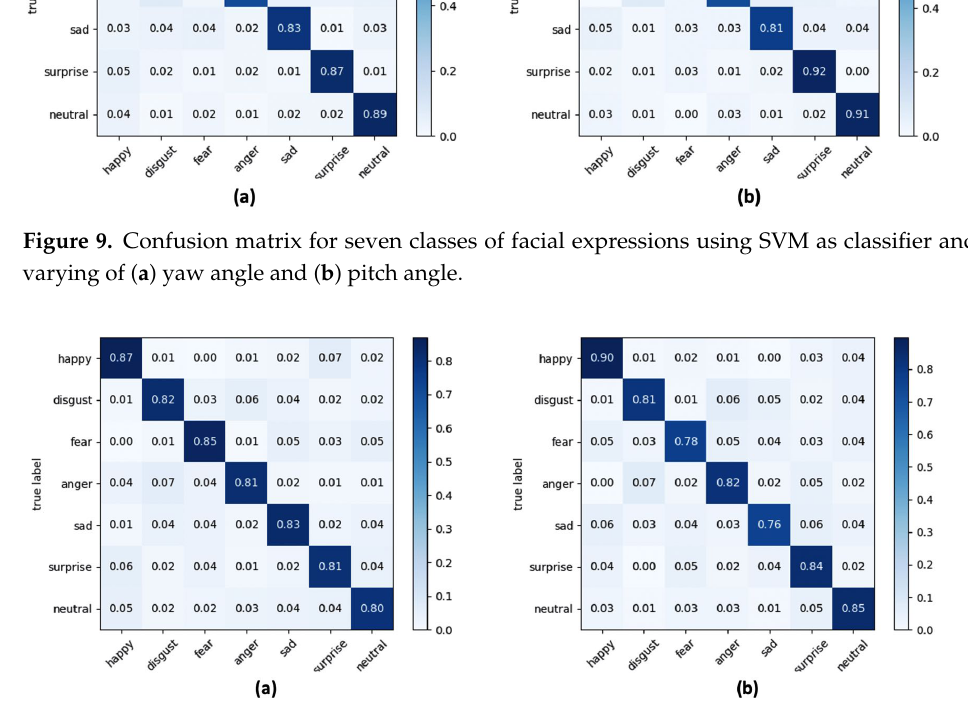
Figure 10. Confusion matrix for seven classes of facial expressions using LR as classifier and at varying of ( a ) yaw angle and ( b ) pitch angle.